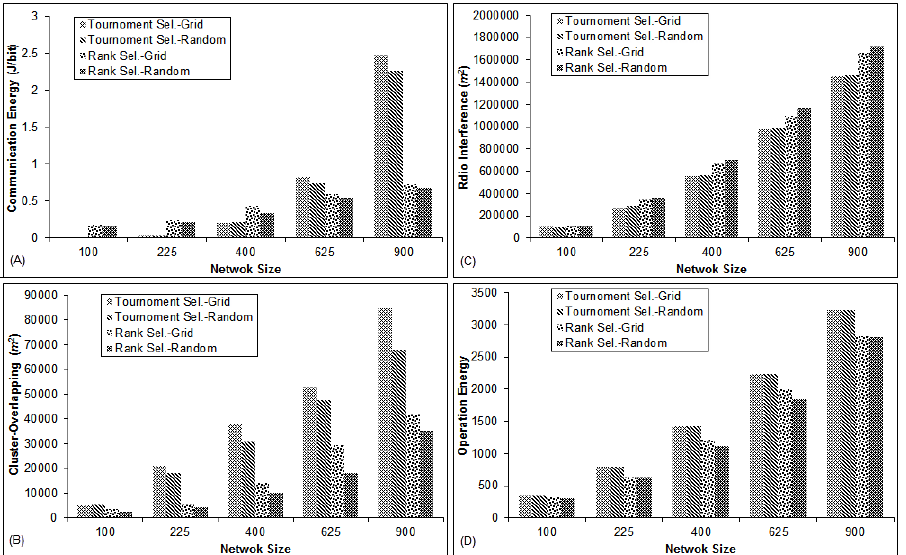
Figure 2. Communication energy (A), cluster-overlapping (B), radio interference (C), and operation energy (D) versus network sizes under different selection